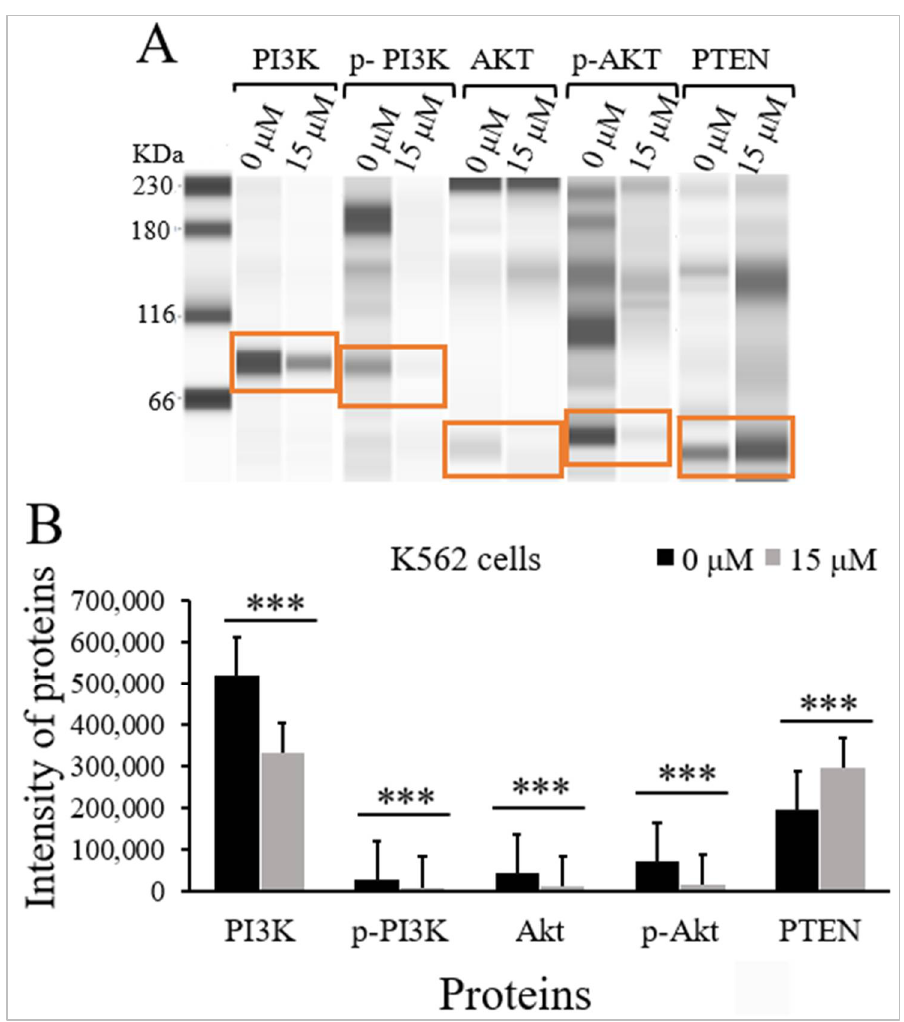
Figure 5. Effect of TQ on the activation of PI3K/Akt/mTOR signaling in K562 cells. The cells were incubated for 48 h with 15 μM TQ. The protein levels were determined by Jess simple western analysis. ( A ) Images of Jess simple western analysis for the target proteins before and after TQ treatment. ( B ) The bar graph demonstrates the reduction of PI3K, p-PI3K, Akt, and p-Akt, and the increase in PTEN protein levels in K562 cells after treatment with TQ. Wilcoxon signed rank test was conducted, and the results are presented as medians and interquartile range (error bars) (n = 3), *** p < 0.001 is significant versus untreated control cells.